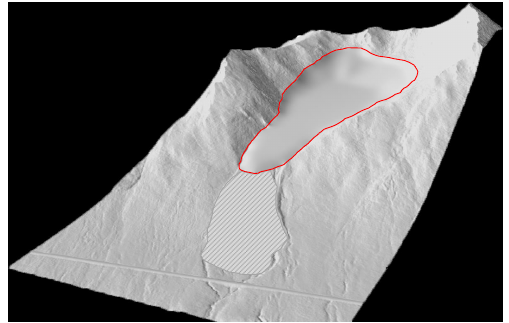
Figure 9. Reconstruction of paleosurface of FDL-A based on bench elevations in its catchment. The reconstructed lobe is outlined in solid red for visibility. The current lobe extent that was removed for the reconstruction is indicated by the area with gray diagonal lines. (Base map data from Hubbard et al.,